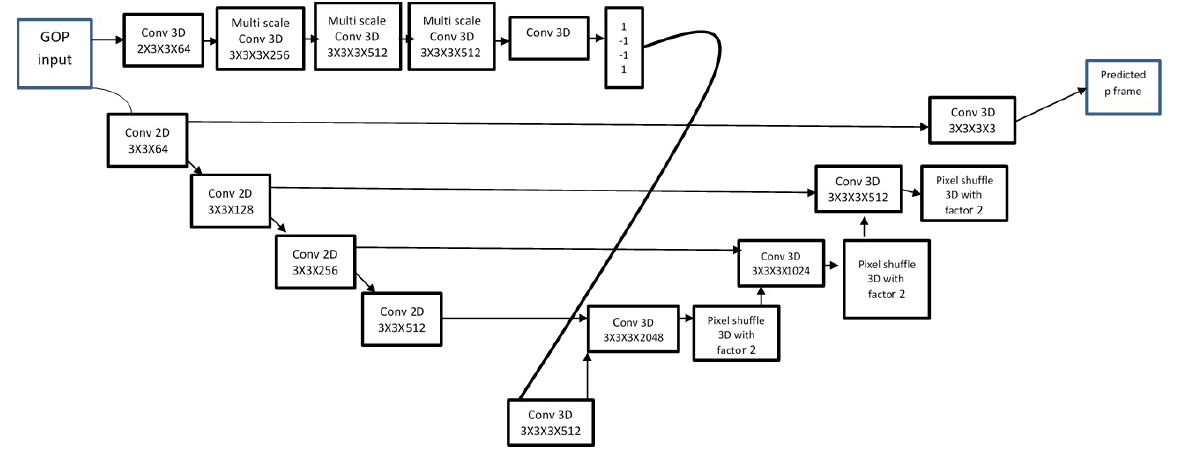
Fig. 5. The model of Deep CNN